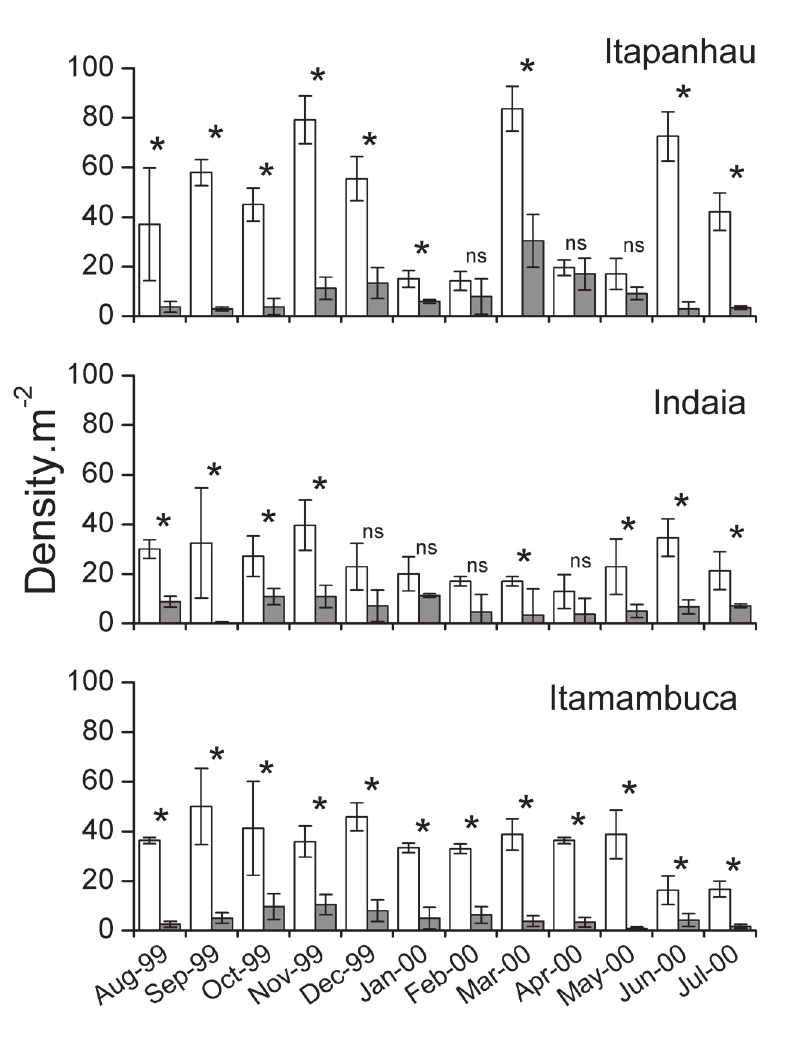
Figure 6. Mean density (standard deviation) of burrows (white columns) and Minuca vocator (Herbst, 1804) (gray columns), recorded with quadrat technique (QT) throughout the year, in the studied mangroves. *, statistical significance. ns, no significant (Student’s